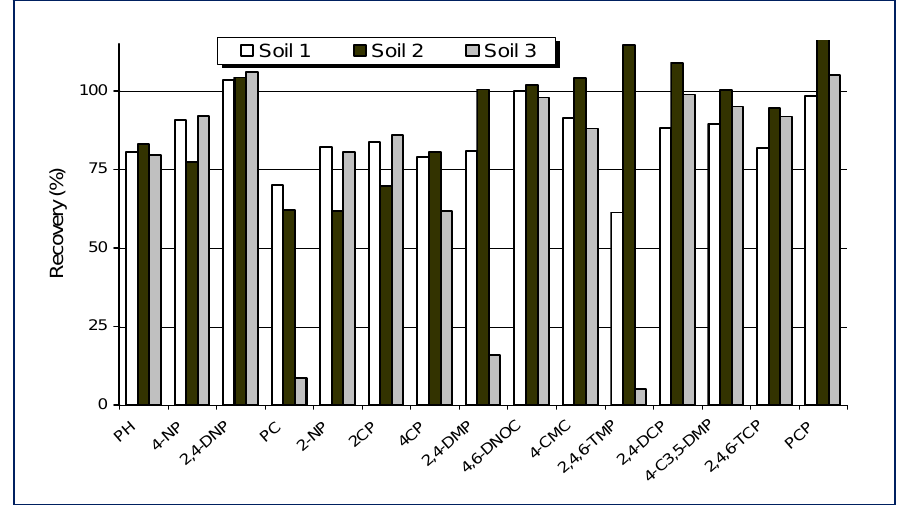
Figure 3 . Recoveries obtained for phenolic compounds in three different soil samples after MAME procedure (from Ref. [88]).